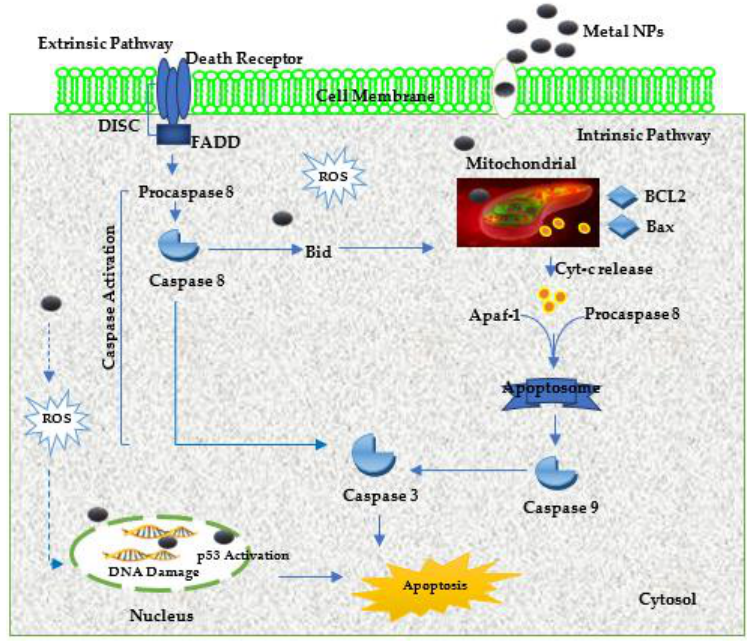
Figure 2. Schematic representation of the metal nanoparticles’ anticancer mechanism of action via extrinsic and intrinsic apoptosis pathways.